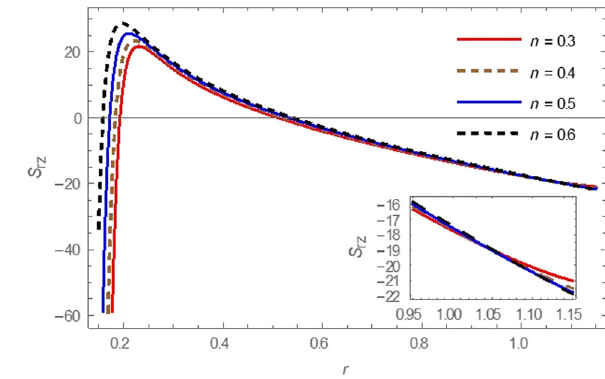
Figure 15: E ff ect of di ff erent values of n on stress with W